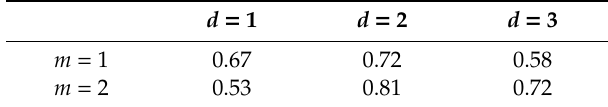
Table 11. Priority index of each distributor by each manufacturer.